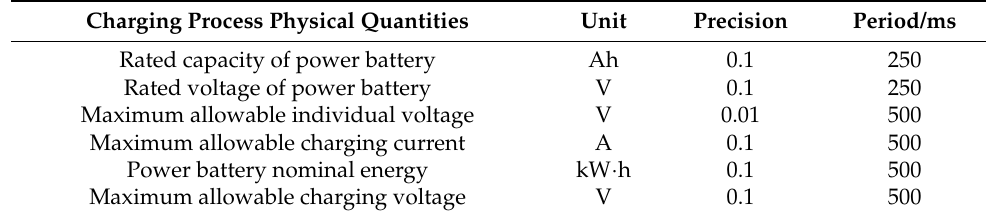
Table 1. Physical quantities of EV charging